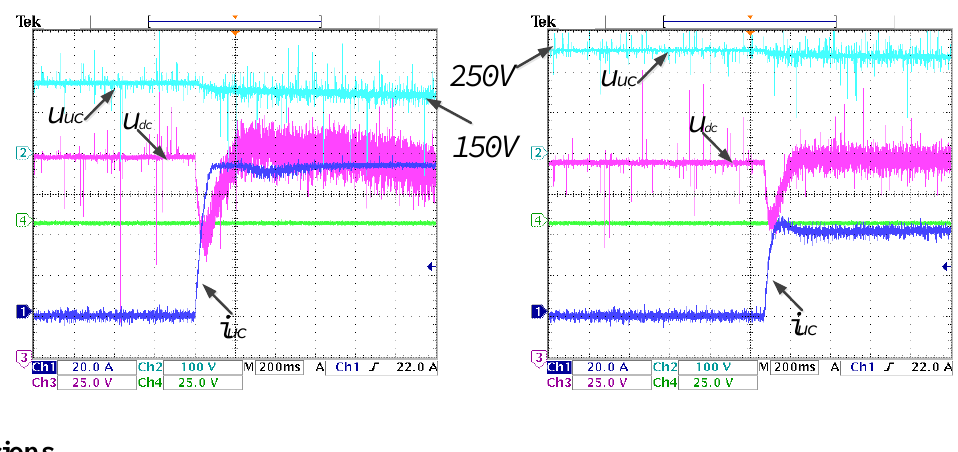
Figure 13. Dynamic waves under condition of DC load change with 150 V and 250 V UC